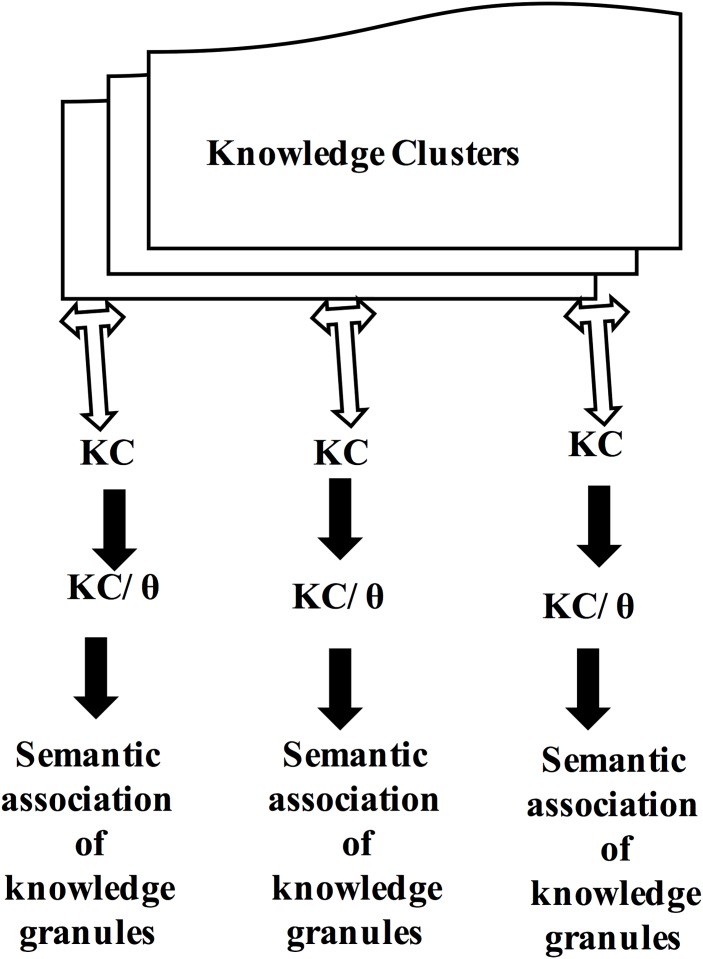
Basic correlation of KCs.